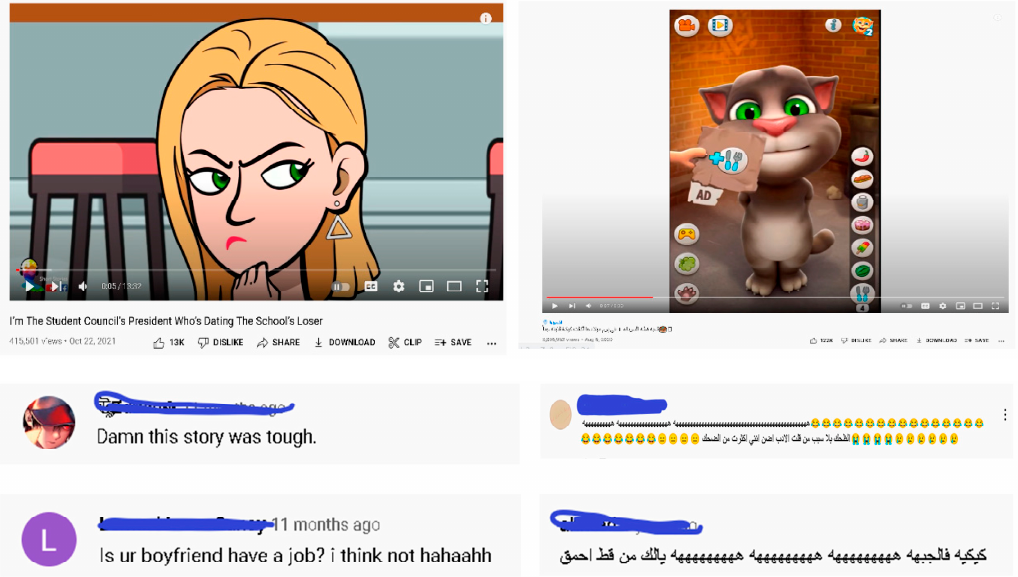
Figure 6. Kid’s video with user